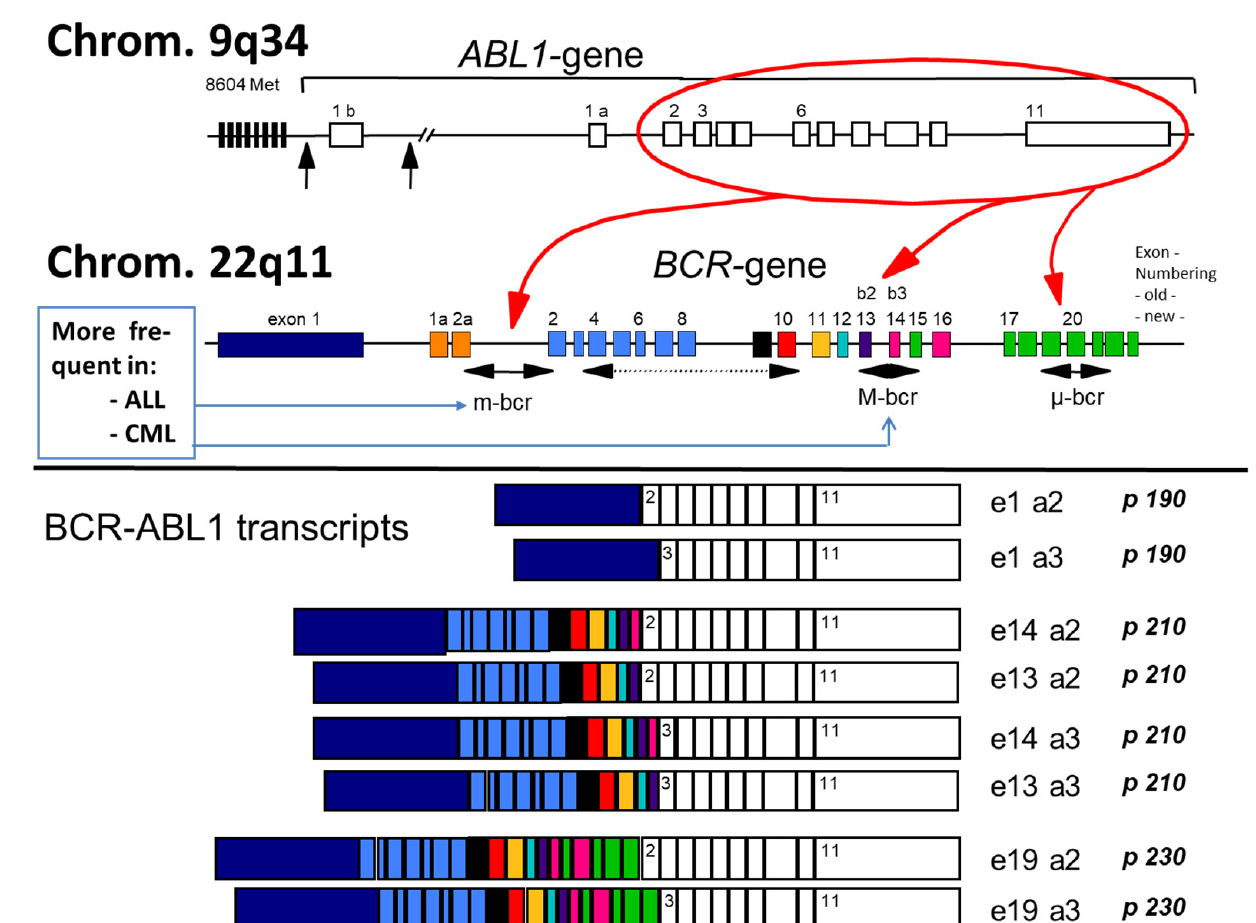
Figure 1. Gene breakpoints and resulting transcript types. Intronic breakpoints (vertical black arrows) of the ABL1 gene and intronic breakpoints of the BCR gene (black horizontal arrows) and the corresponding fusion proteins (Length of exons and introns not according to scale). Pseudoexons 1a and 1b on the ABL-gene as well as pseudoexons 1a and 2a on the BCR-gene are spliced out. In CML, the most frequently observed M-bcr breakpoint and the less frequently and only rarely observed breakpoints m-bcr and µ -bcr, respectively, can produce eight m-RNA fusion transcripts and translated proteins because of alternate splicing of the ABL1-gene exon 2 and because of two internal breakpoints in intron 13 and intron 14 of the BCR-gene. Additional breakpoints (indicated by a dotted horizontal arrow in this cartoon) have been described rarely or only as single case.